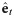
Typical GEM (solid curve) for the shuffleboard task, obtained as zeros of the goal function Eq (2), plotted in the dimensionless (x, v) body state space.Dashed curves indicate ±10% constant error contours at the goal (as a percentage of distance to the goal). For this particular plot, μ ≈ 0.016. Also shown are the unit vectors tangent and normal to the GEM, e^t and e^n, near a representative operating point x* (Eqs (5) and (6)): small deviations along e^t do not cause error at the target (i.e., they are goal equivalent), while deviations along e^n do (i.e., they are goal relevant). Note that the distance between contours increases from left to right, indicating a decrease in passive sensitivity (see Eq 8) along the GEM.